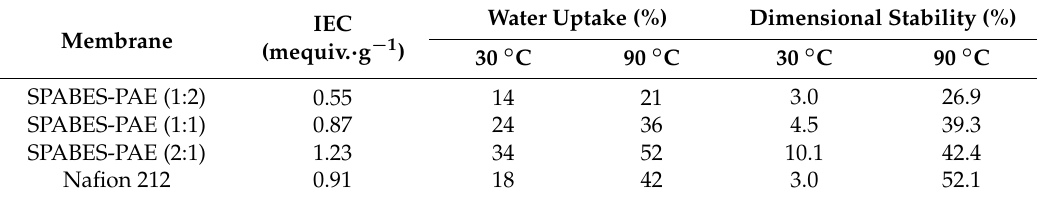
Table 3. Ion exchange capacity (IEC), water uptake, and dimensional stability of SPABES-PAE and Nafion 212 membranes.